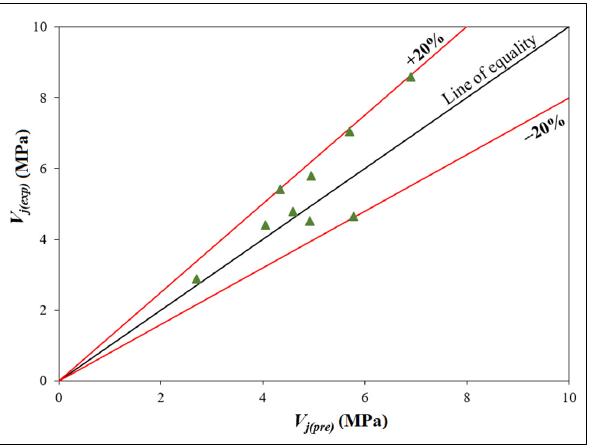
Figure 12. Comparison of experimental and predicted values for the shear strength of joints.